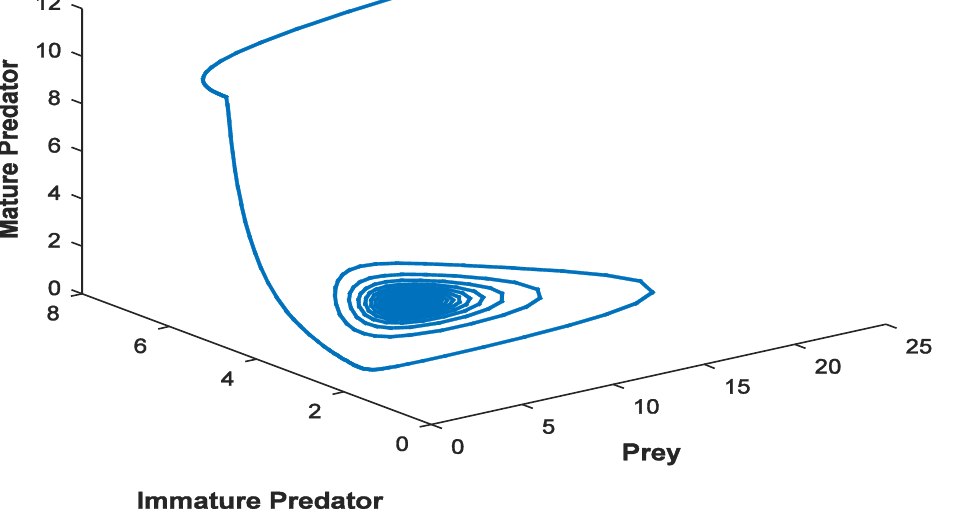
Figure 2. Phase portrait for T=2.2.